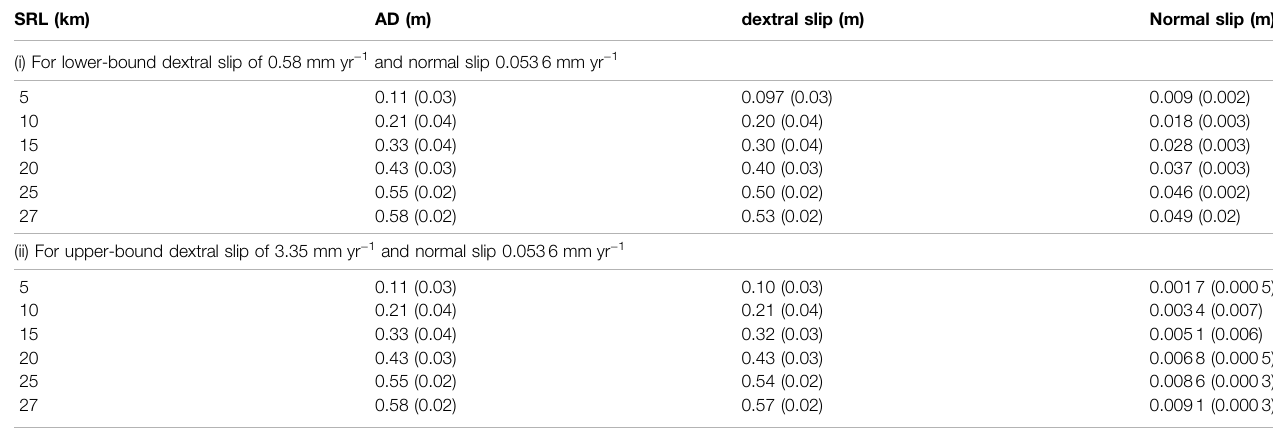
TABLE 4 | Values of average displacement (AD) (1 σ errors in parentheses) across the Akhisar-Kiliç fault segment for given surface rupture length (SRL) derived from Eq. 13 . Strike-slipandnormalslipcomponentsarecalculatedbasedontheratiobetweendextralslipandnormalslipcomponentsofgradualannualsliponthesegmentoverthe past 2 Ma for given lower 1) and upper 2) bound slip rates as reported in Krystopowicz et al. (2020).